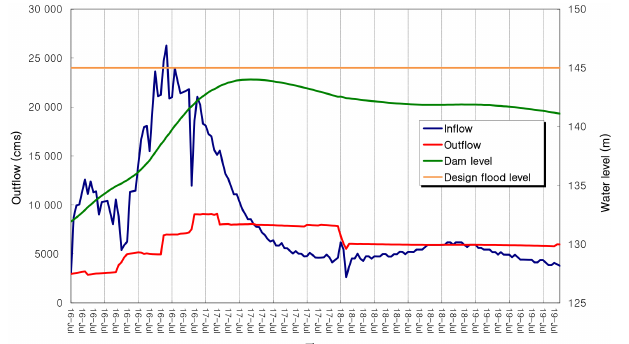
Figure 3. Flood control by Chungju dam in 2006